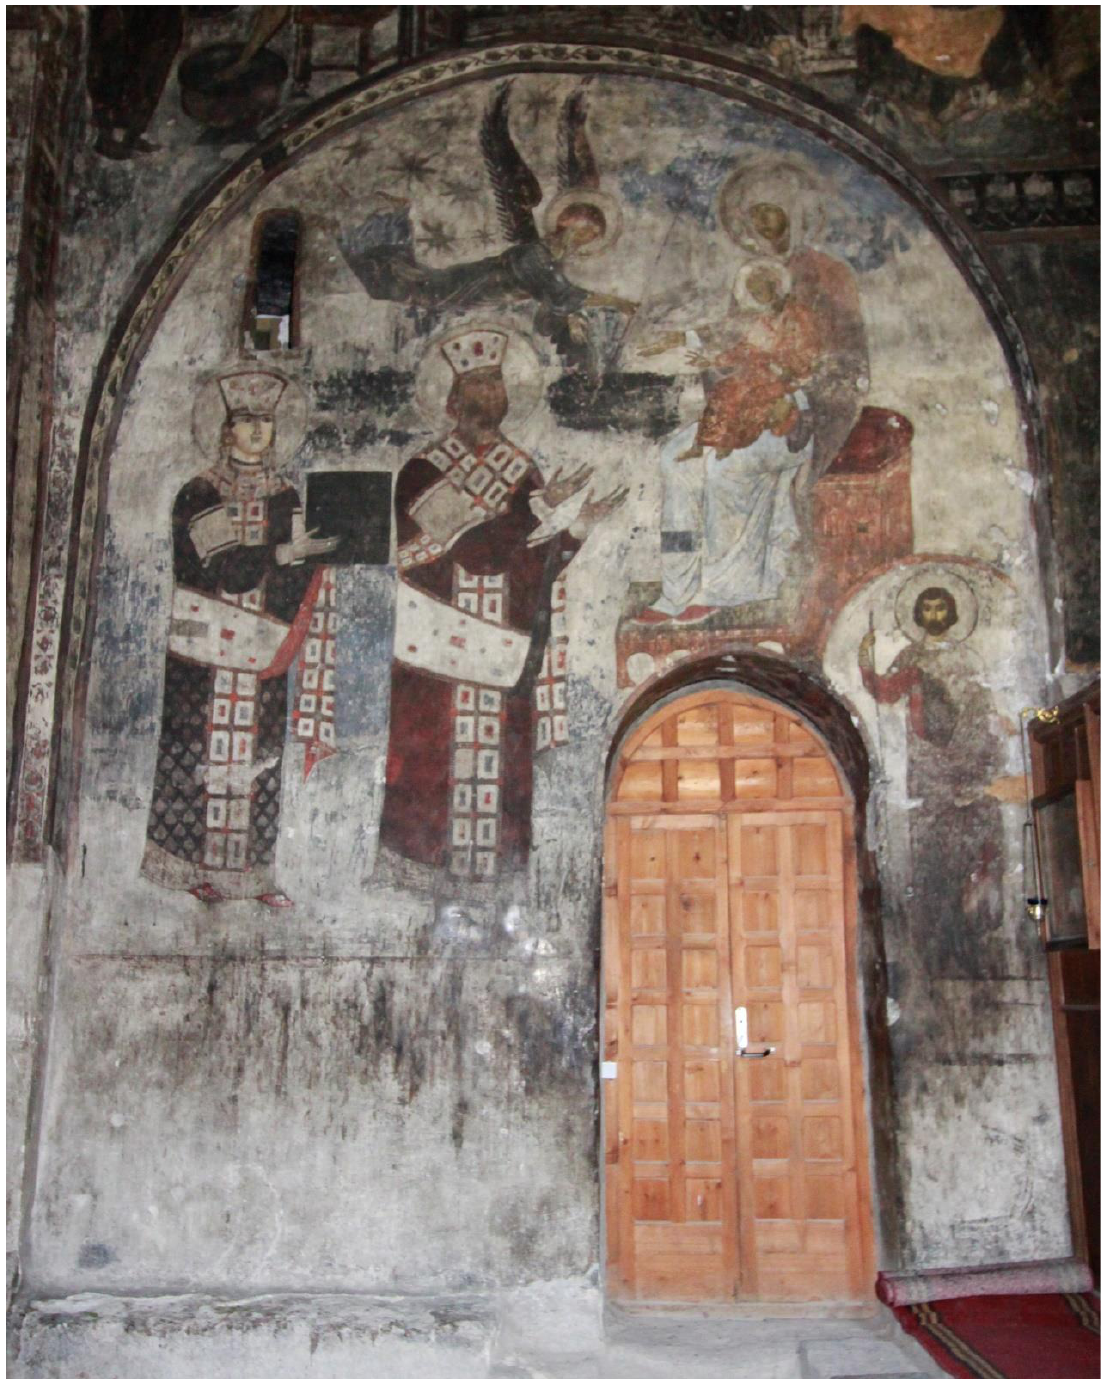
Figure 1. Queen T’amar with her father King Giorgi III, fresco, 1180s, main church of Vardzia